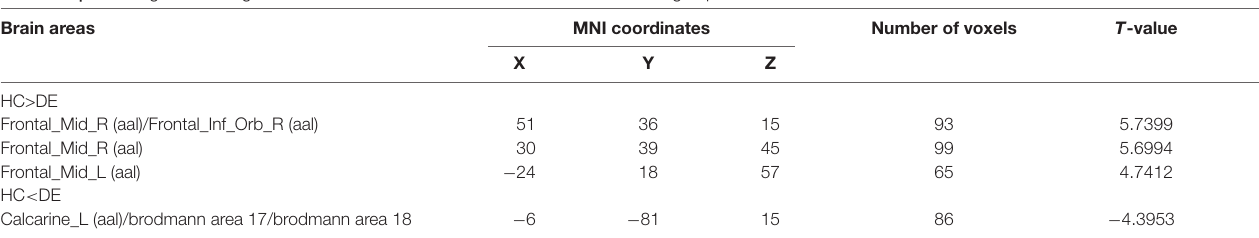
TABLE 2 | Brain regions with significant differences in fALFF values between DE and HC